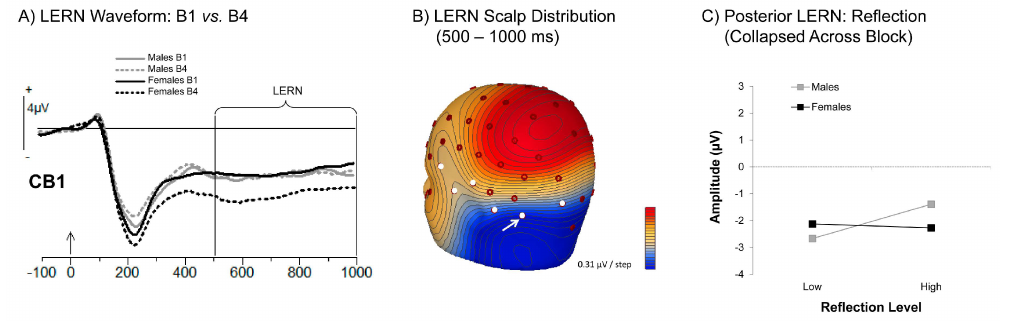
Figure 6. Learning Error-Related Negativity (LERN). ( A ) LERN grand mean waveforms plotted at CB1 for the first (B1) and last (B4) blocks, as a function of gender; ( B ) Scalp distribution of the LERN plotted for all subjects, collapsed across all four blocks. Left hemisphere electrodes included in the analysis are highlighted in white, with an arrow pointing to CB1; ( C ) Null effects of Reflection on Posterior LERN